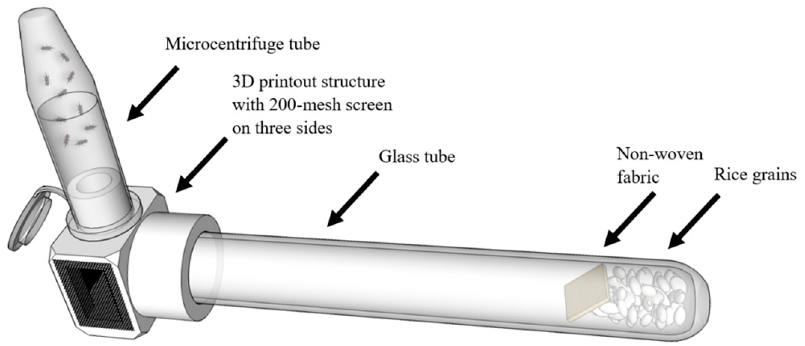
Figure 1. Schematic diagram of attraction–inhibitory activity assay.